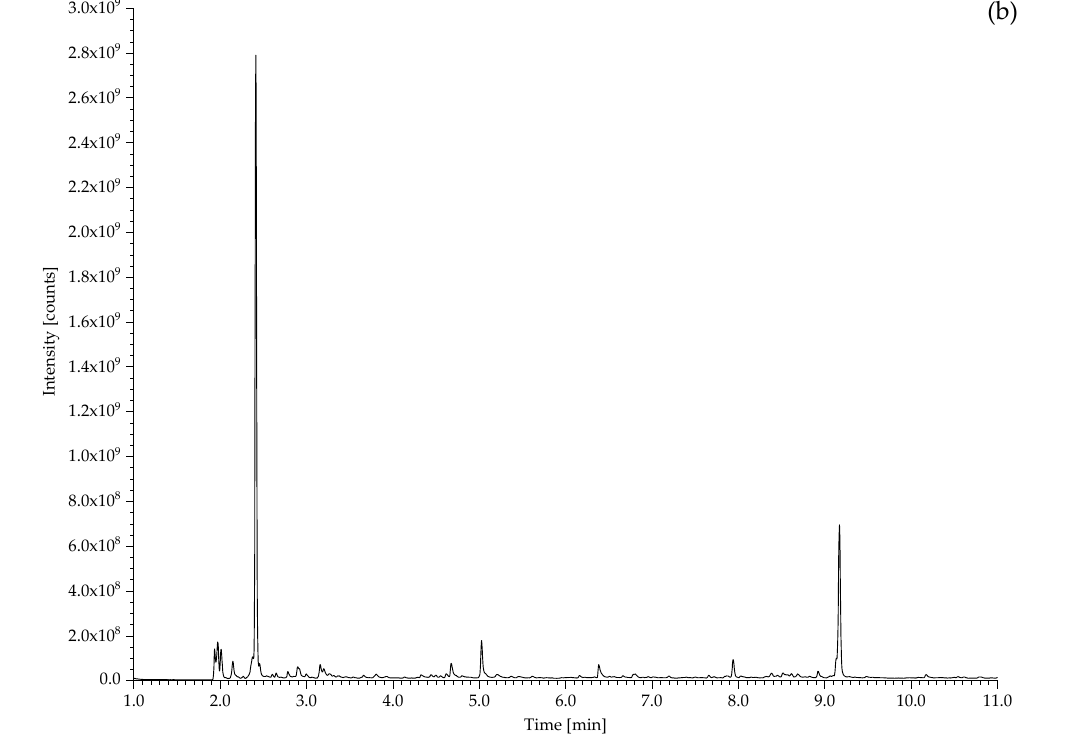
Polymers 2022 , 14 , x Figure 8. Pyrogram of sample 431 ( a ) and a zoomed ‐ in view of the same pyrogram ( b ). Figure 8. Pyrogram of sample 431 ( a ) and a zoomed-in view of the same pyrogram ( b ).